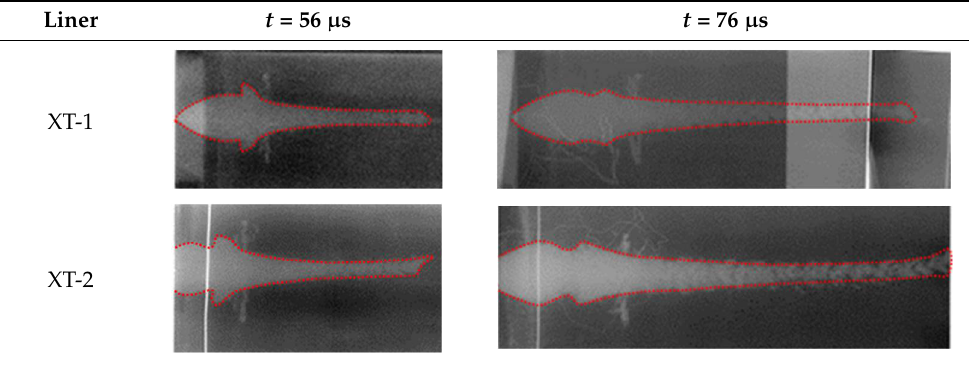
Table 1. X-ray test results.